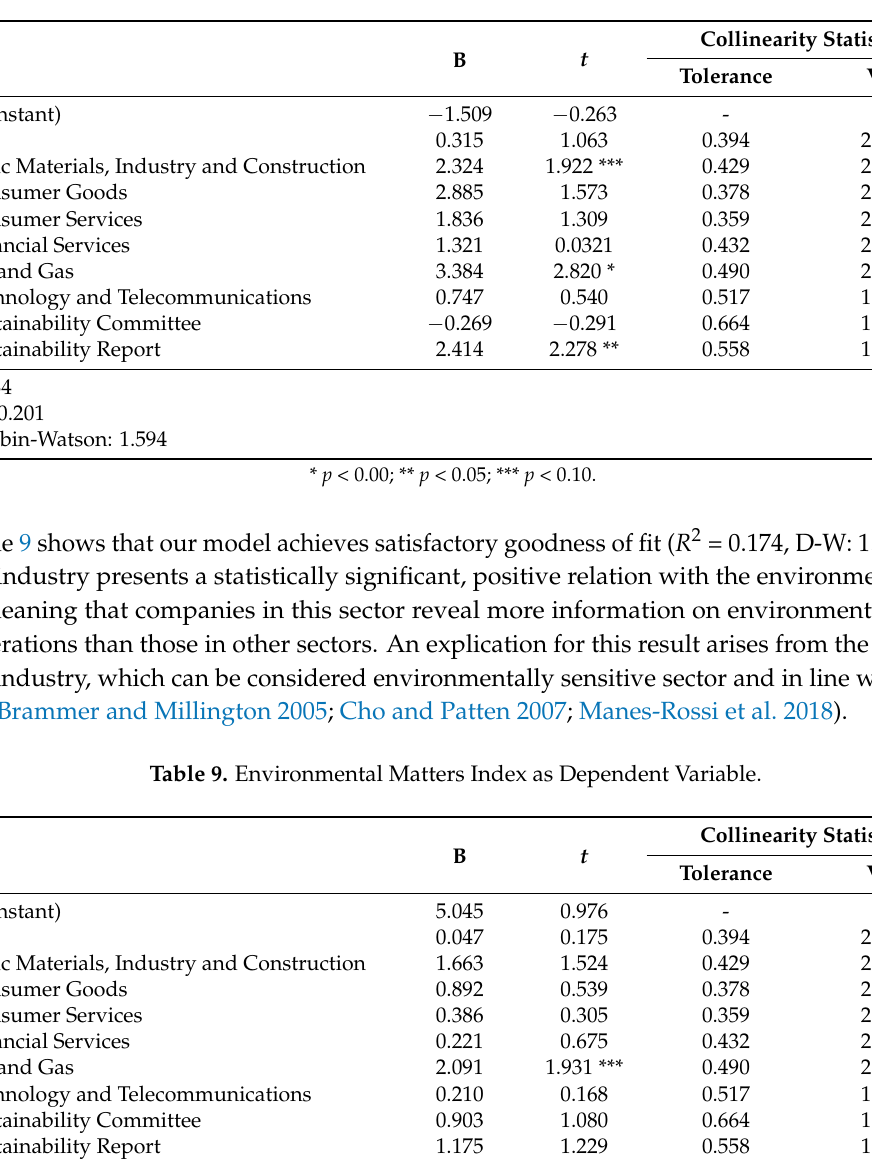
Table 8. Non-Financial Statement Content Index as Dependent Variable.